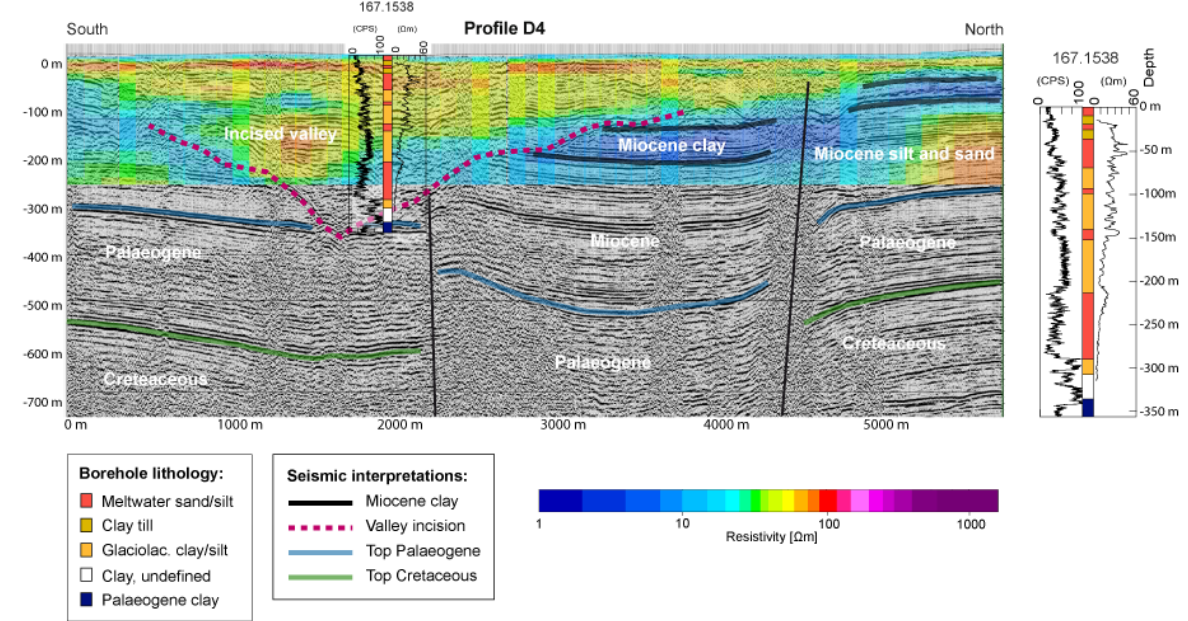
Fig. 6. Interpreted seismic section (profile D4) with SkyTEM resistivity data showing the Tønder Graben with subsided Miocene and Palaeo- gene layers and a deep, buried tunnel valley. A new deep borehole (archive no. 167.1538, GEUS, 2012) drilled on the section is shown with lithological sample descriptions. The IN and NG logs obtained in the open well are shown on the section, too. For location of the section, see Figs. 5 and 9. Vertical exaggeration 3 × .